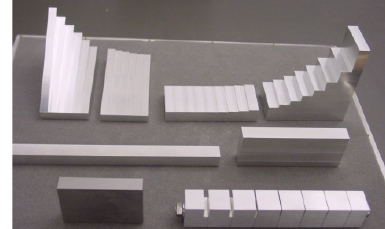
Figure 11. 3D colour laser scanning with an Arius3D Foundation system mounted on a Newport Goniometric Stage. The capabilities of the scanner are given in (Hess et al. 2011)(http://www.arius3d.com/a3d_specs.html)